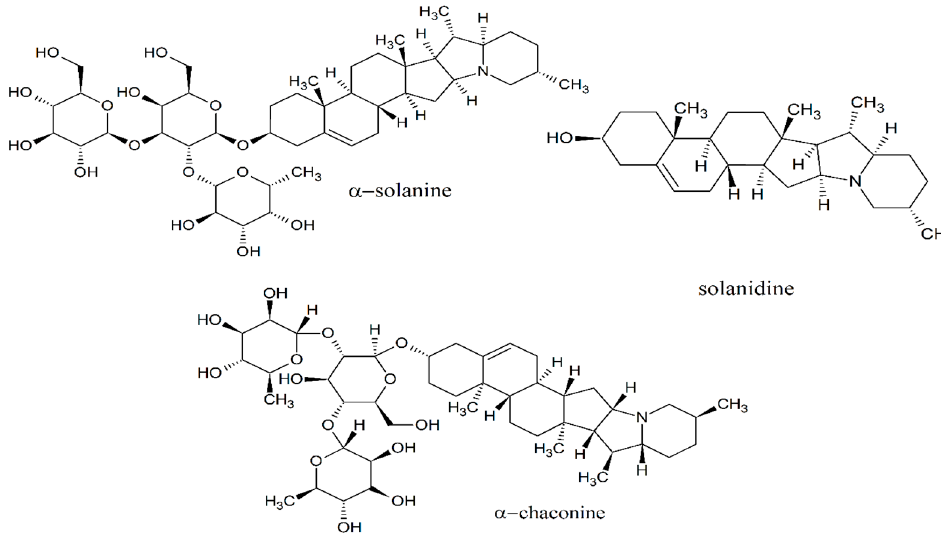
Figure 2. 2D-structures for the main alkaloids found in potato tubers [10].